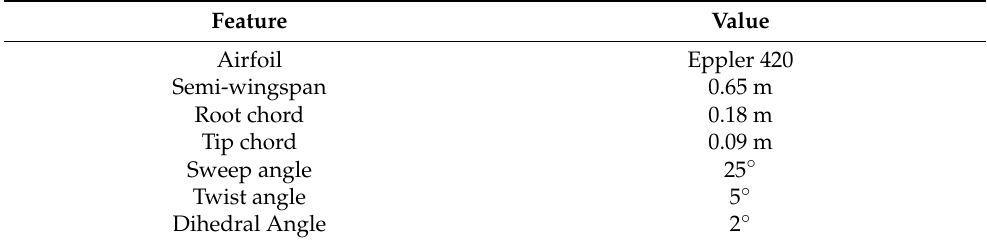
Figure 2. Top view of the designed wing with the winglet. Table 1. Features of the designed wing.